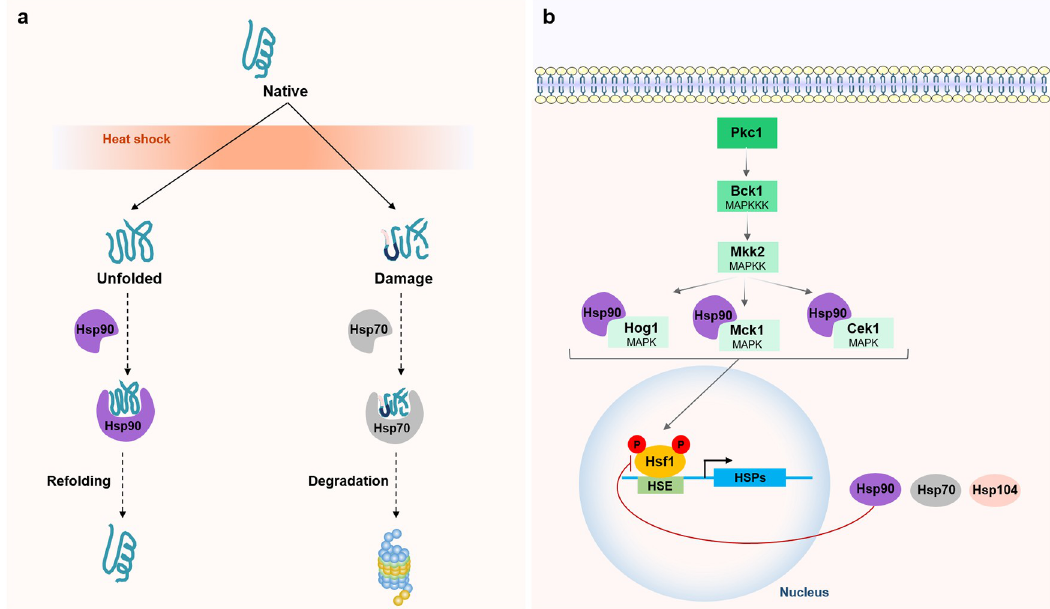
Fig 5. Molecular circuits required for thermal adaptation in C . albicans . (a) HSPs rescue proteins from unfolding or target damaged proteins for degradation. (b) In response to temperature upshifts, Hsf1 becomes phosphorylated, inducing the expression of HSP genes. After thermal adaptation, Hsf1 returns to basal levels through a negative feedback loop dependent on Hsp90. Long- term adaptation is controlled by Hsp90 through Hog1, Mkc1, and Cek1. HSE, heat shock element; Hsf1, heat shock transcription factor 1; HSP, heat shock protein; MAPK, mitogen-activated protein kinase; MAPKK/MAPKKK, MAPK kinase/ MAPKK kinase.